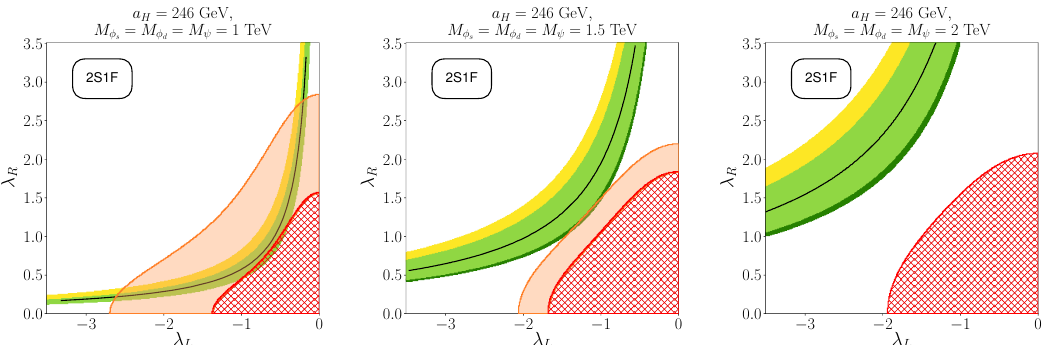
Figure 9. Results from Model 2S1F, scanning over the couplings of the new scalars and fermion to the left- and right-handed muon. All BSM fields have identical masses as specified in the subfigures. The trilinear coupling which parametrises the mixing of the neutral BSM scalars is fixed to a = 246 GeV. Regions which can explain ∆ a BNL and ∆ a 2021 to within 1 σ are coloured H µ µ yellow and green respectively, while the overlap between these two regions is coloured lime. The black line marks couplings which produce a contribution which exactly matches eq. (1.7). The points where a dark matter candidate particle produces the observed relic abundance of 0 . 1200 , eq. (1.8), are at the boundary of the hatched region shown in red, with the hatched region below and to the right being excluded due to having a relic abundance greater than 0 . 12 . Regions excluded by searches for the direct detection of dark matter at the Xenon1T experiment [506, 507] are shaded in